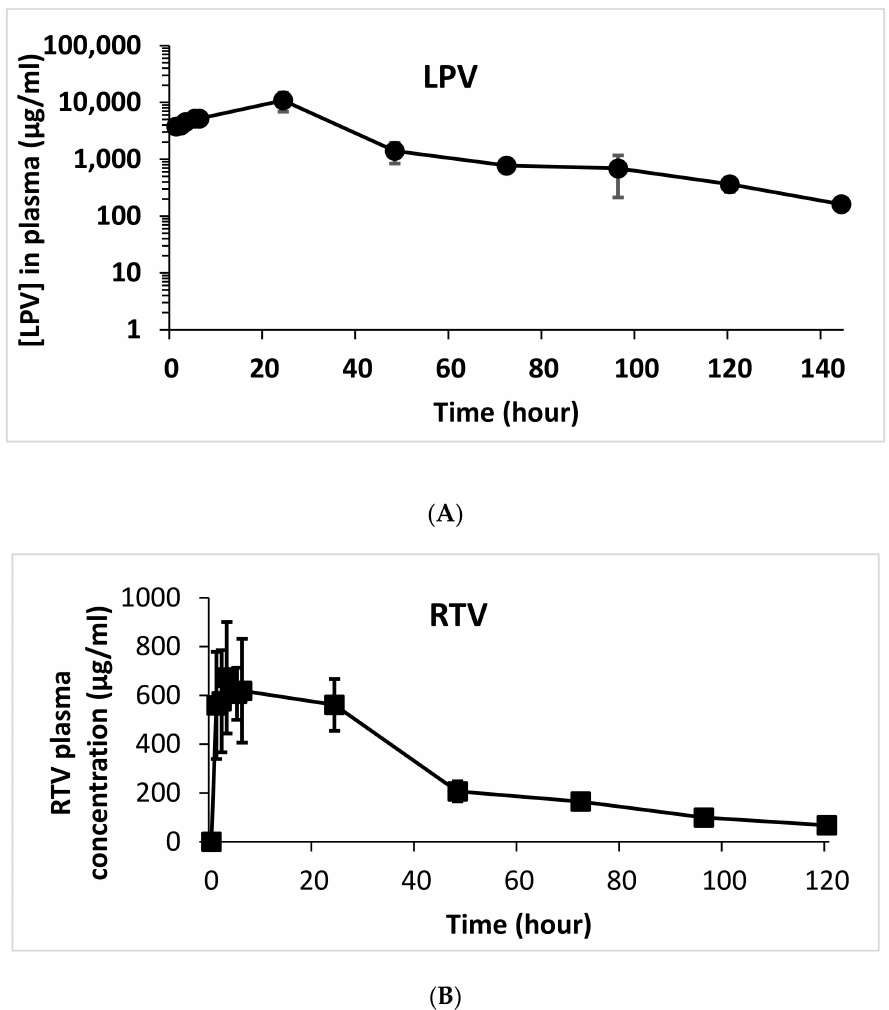
Figure 5. Pharmacokinetics of the ISNP-based LPV/RTV injection in rats over 6 days for LPV ( A ) and RTV ( B ). The ISNP-based LPV/RTV injection was given to rats by subcutaneous injection at 100 mg/kg of LPV. Plasma samples were analyzed by a validated LC-MS method. Data are presented as the mean ± SD ( n =